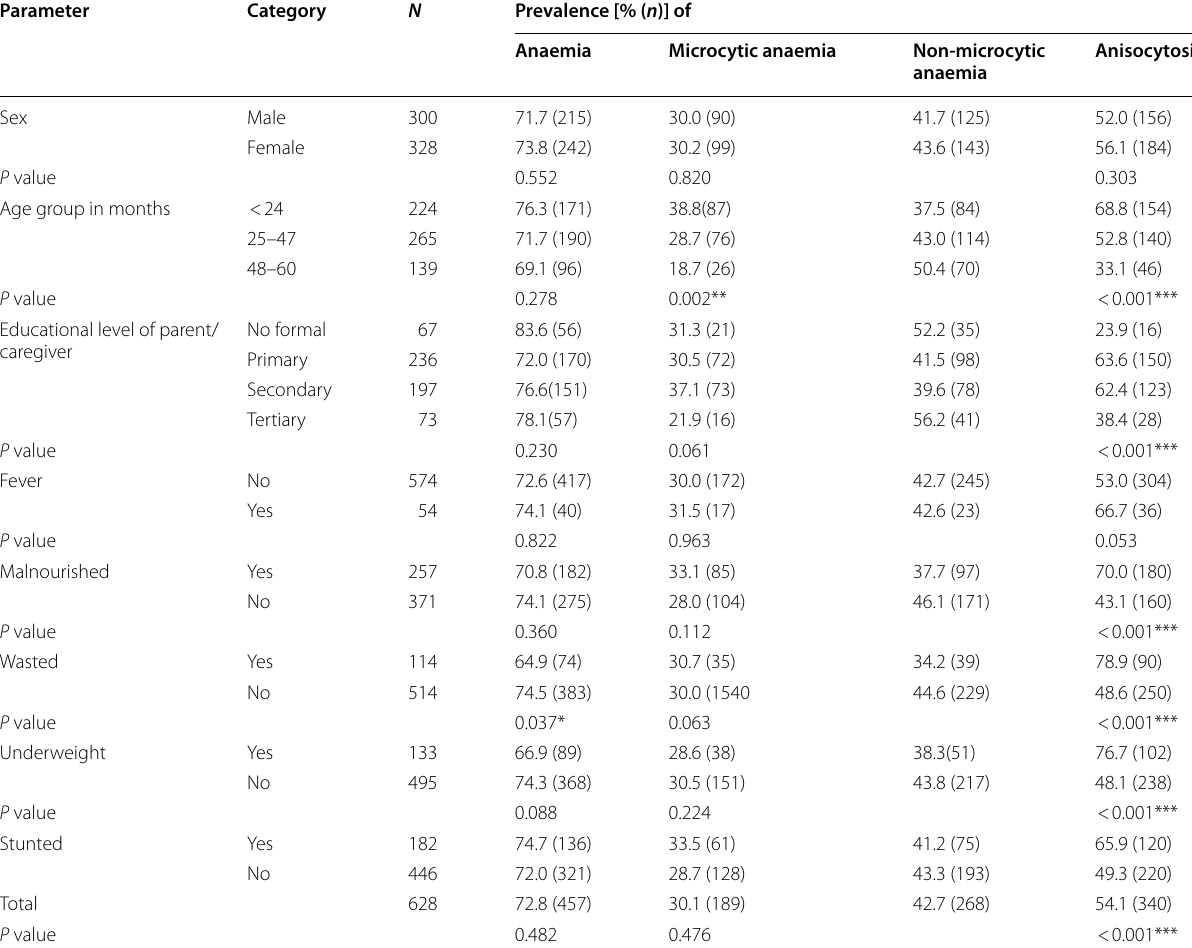
Table 4 Prevalence of anaemia, microcytic anaemia, non-microcytic anaemia and anisocytosis with respect to socio-demographic and clinical